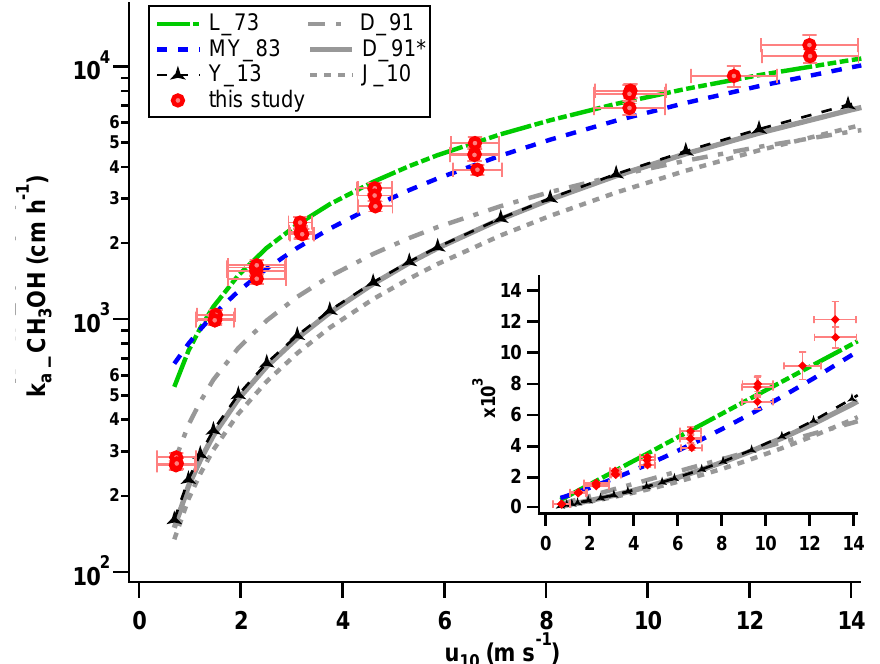
Figure 11. Comparison between the CH 3 OH measurements of this study (red circles) and previous k a parameterisations. Experimental studies are presented with coloured lines: L_73: Liss (1973); MY_83: Mackay and Yeun (1983); and Y_13: Yang (2013), while model studies are given with grey lines: D_91 using the M ; D_91 ∗ using the Sc a : Duce et al. (1991); and J_10: Jeffery et al. (2010) using a Smith and Banke (1975) derived drag coefficient